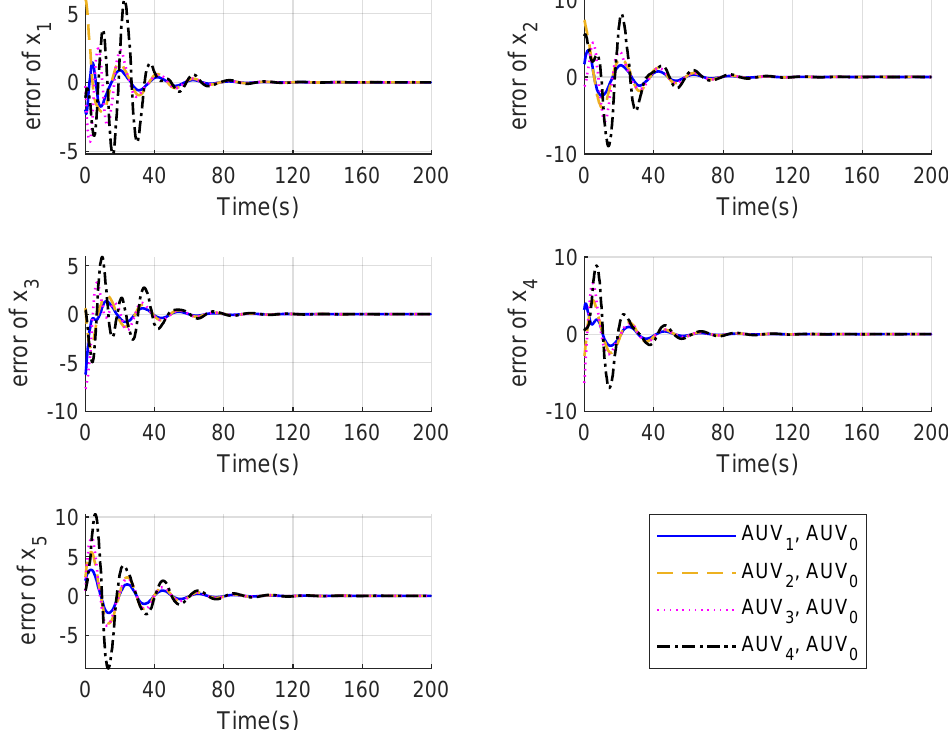
Figure 14. Errors of position state under alterable communication topology with delay.